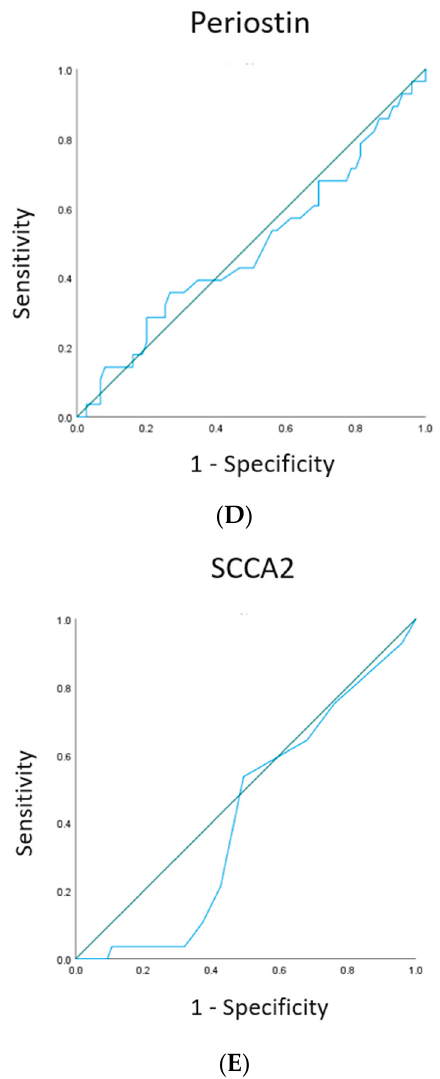
Figure 2. ROC curves obtained with serum JCP-specific IgE ( A ) (decision point, ≤ 100.3 UA/mL; sensitivity, 66.7%; and specificity), 61.3%, IgG ( B ) (decision point, ≤ 11.6 UA/mL; sensitivity, 60.0%; and specificity, 72.0%), IgG4 ( C ) (decision point, ≤ 989.5 UA/mL; sensitivity, 93.3%; and specificity, 94.7%), periostin ( D ) (decision point, 89.5 ≤ UA/mL; sensitivity, 28.6%; and specificity, 80.0%), SCCA2 ( E ) (decision point, ≤ 0.550 UA/mL; sensitivity, 53.6%; and specificity, 50.7%) by plotting data